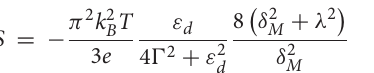
FIGURE 4 | Conductance and thermopower in the presence of the microwave field with 1 d coupling strength λ in (A) , (B) with δ M